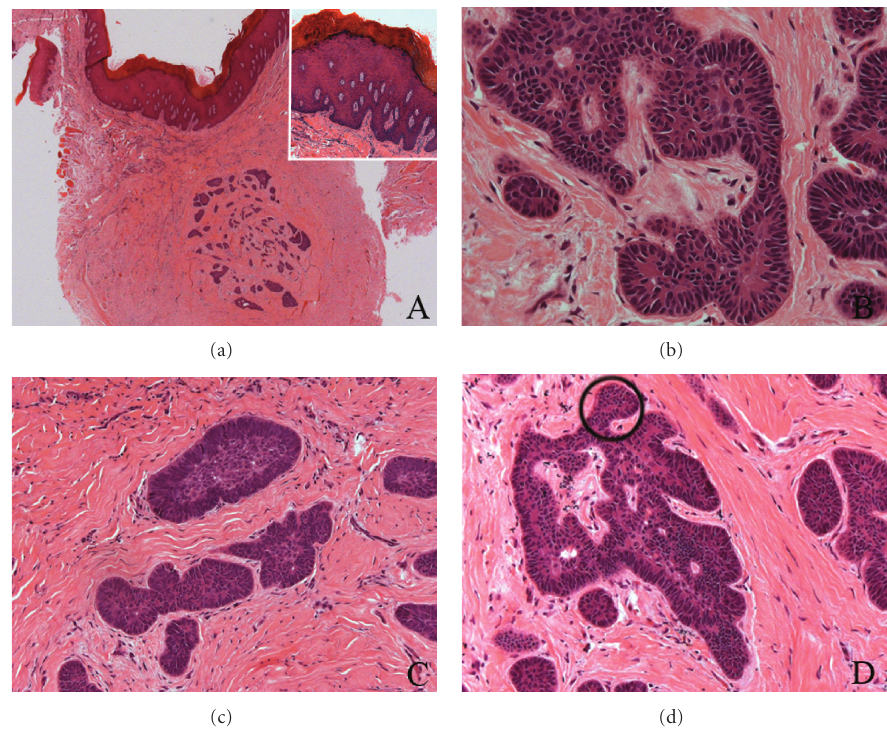
Figure 2: (a) Nondysplastic hyperkeratotic oral epithelium (magnified in the box, H&E, 10x) and the submucous odontogenic epithelial cell islands (H&E, 2,5x); (b) Less mature odontogenic island with vacuolated oval to polyhedric cells (H&E, 40x); (c) ameloblastomatous nest composed by peripheral palisading columnar and central polyhedric cells (H&E, 20x); (d) budding projection in an ameloblastomatous island (circle) (H&E,